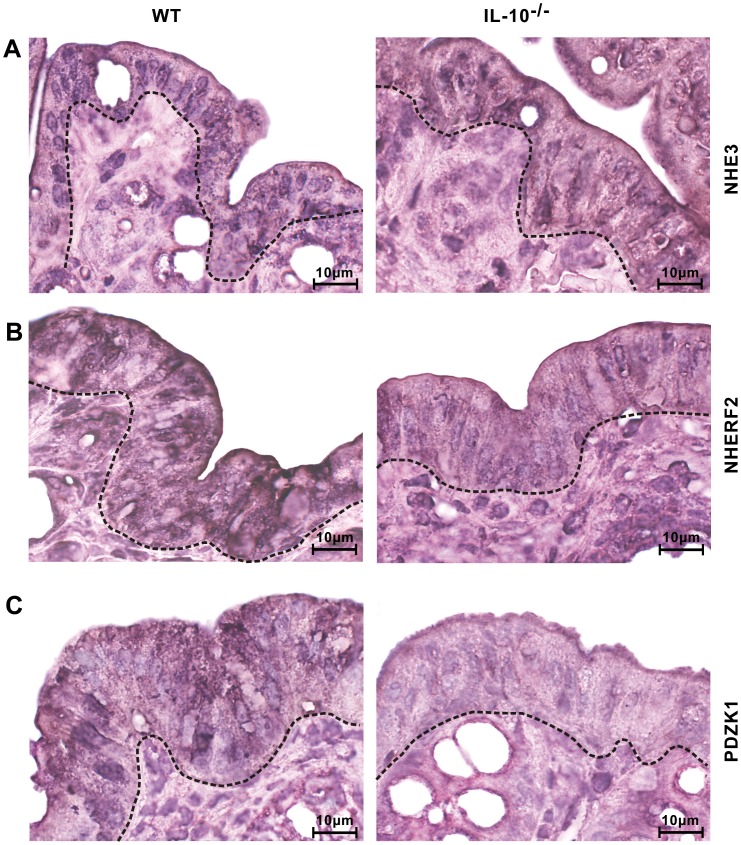
Gene expression by in situ RT-PCR of NHE3, NHERF2, and PDZK1 in the colonic mucosa.(A) Unaltered NHE3 expression levels in enterocytes of the epithelial layer of WT and IL-10−/− mice. (B) mRNA expression of NHERF2 and (C) PDZK1 in the epithelial enterocytes were markedly decreased in IL-10−/− mice. The dashed line separates the epithelial layer from the connective tissue of the lamina propria of the mucosa. Representative images of two independent experiments.